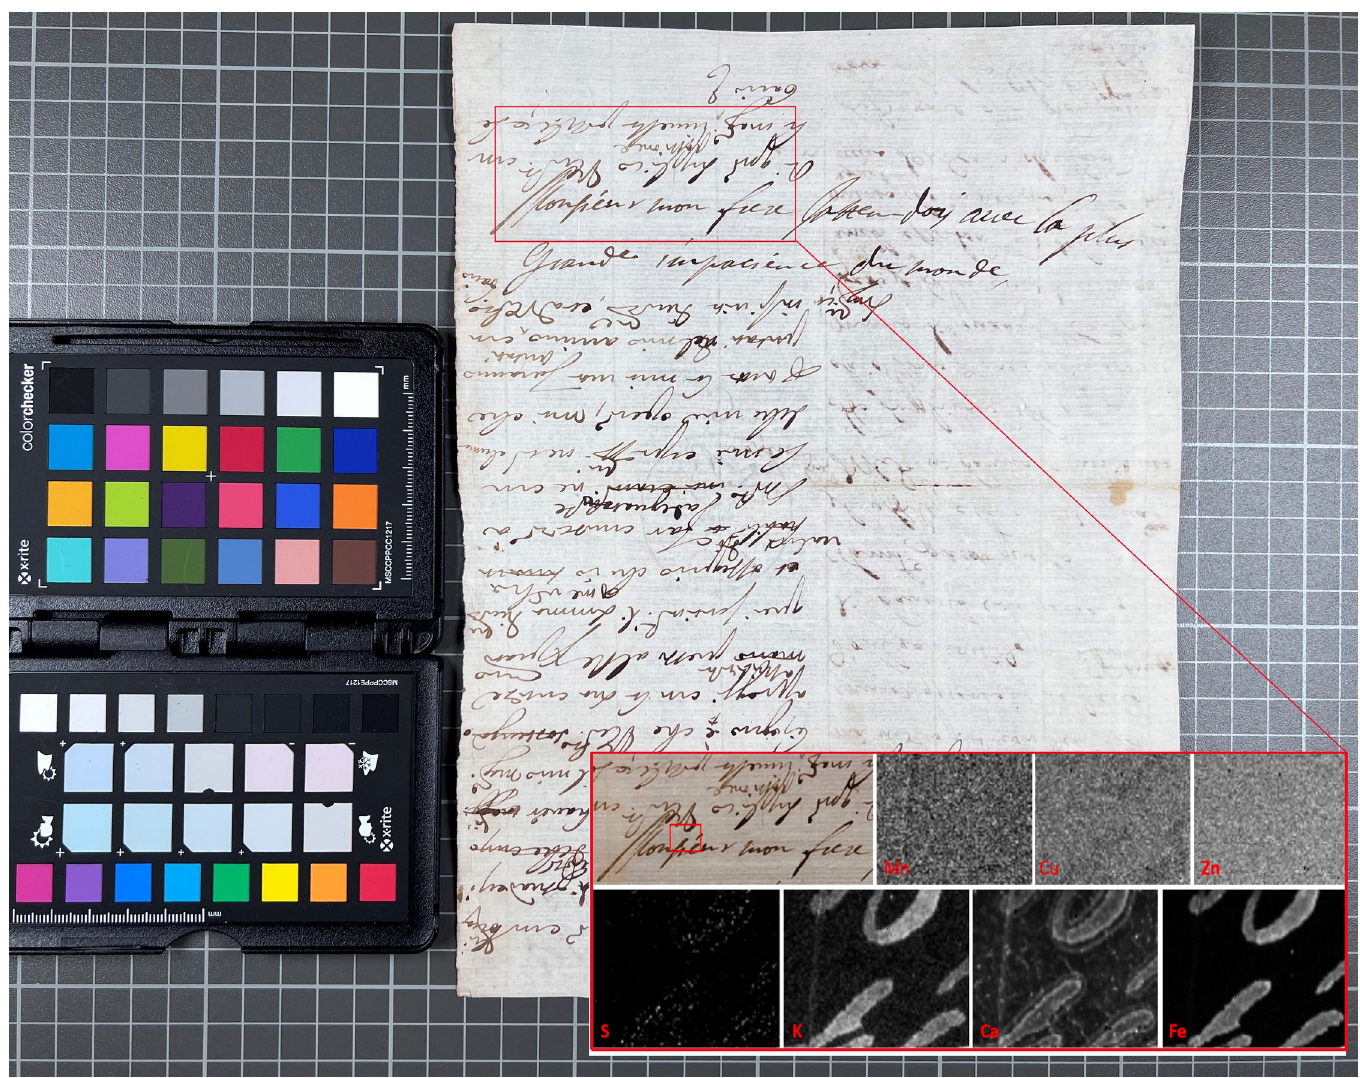
Fig 19. One document, two hands–one ink. XRF map (6532 points) from K403 828 over Azzolino’s (upside down) and Christina’s (right way up) writing. Outliers from dust or other contamination were removed (6 points) to improve contrast in the calcium map. The removed points appear as missing pixels, just noticeable as black dots in the zinc